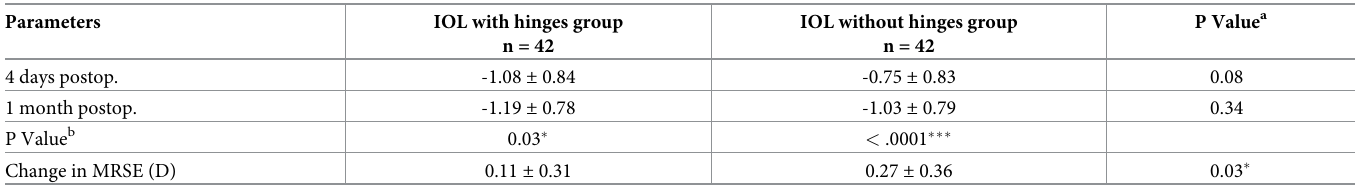
Table 4. Comparison of mean ( ± SD) change in manifest refractive spherical equivalent.